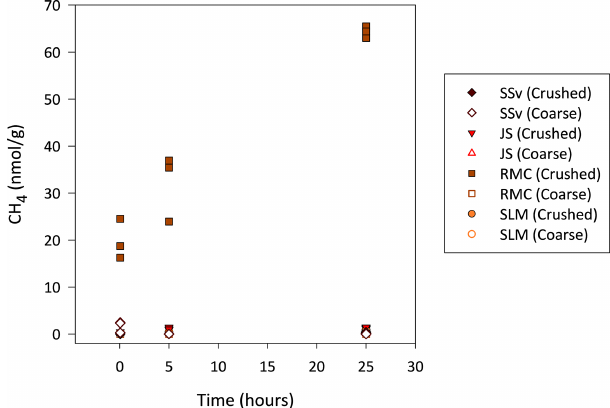
Figure 6. Generation of CH 4 during incubation of coarse (63µm– 2mm) and crushed sedimentary rock and subglacial sediment sam- ples. Headspace gas samples were analysed after 5min, 5h and 25h of incubation, blank corrected and normalised to the grams of sam-